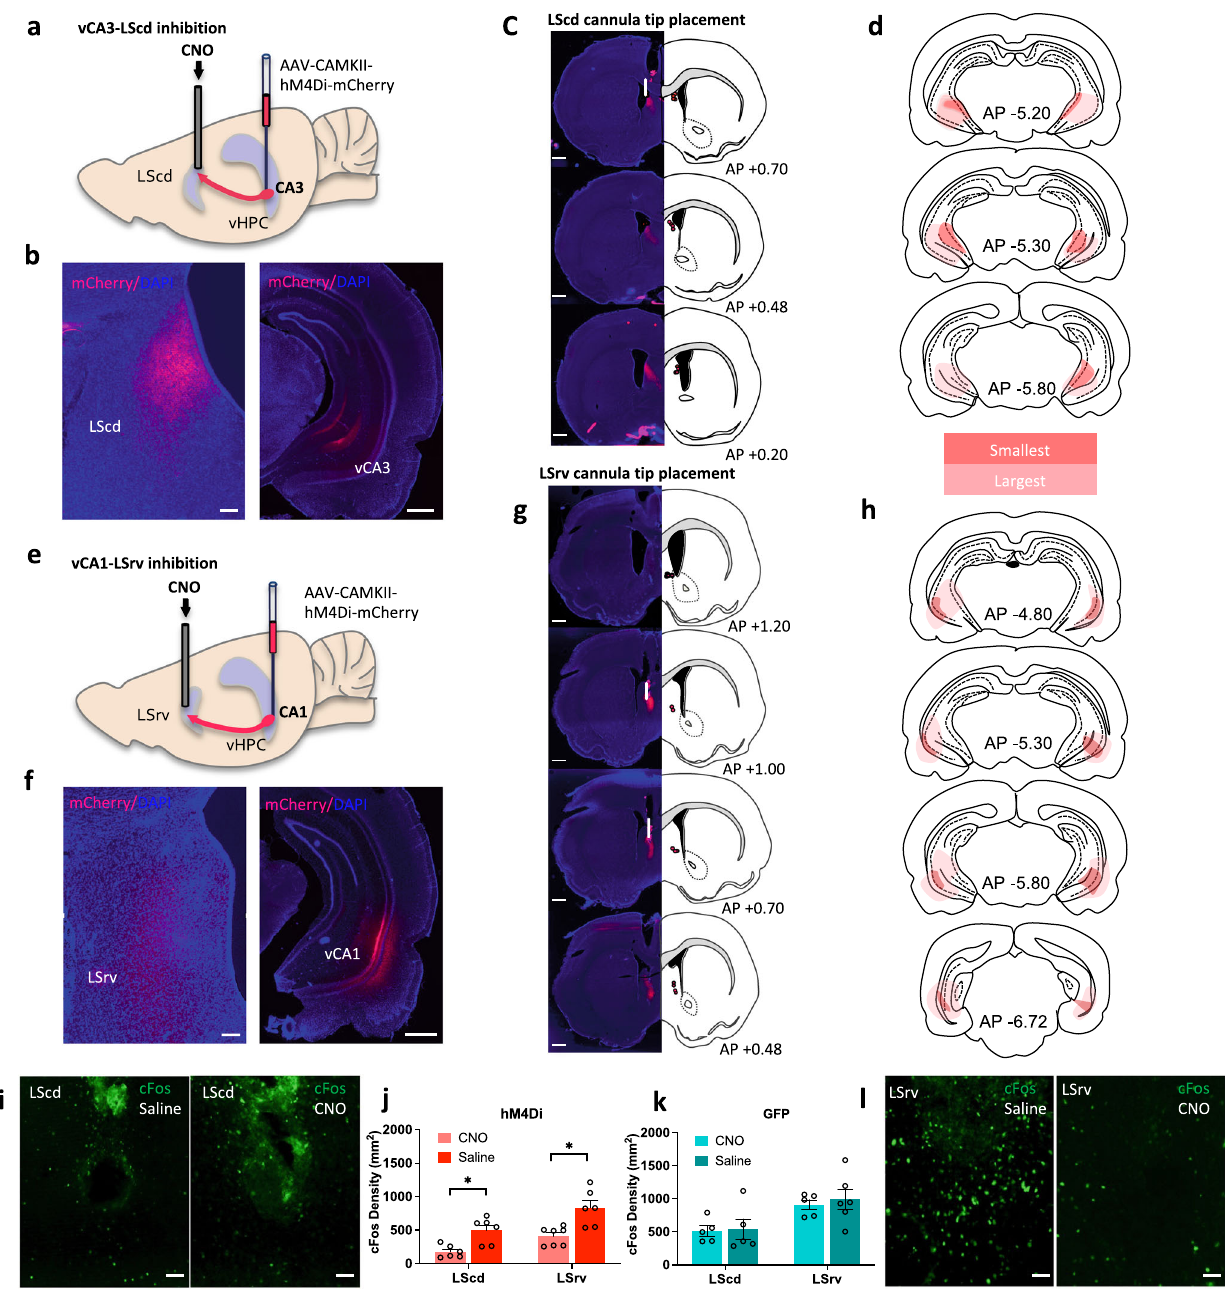
Fig. 2 Experimental schematic and c-Fos results. a Diagram of hM4Di transduction in vCA3 and cannulation in LScd, with b representative DREADDs axonal transduction in the LScd (red) and somatic transduction in vCA3, c cannula placements in the LScd restricted to sections + 0.7 to + 0.2 anterior to bregma 71 , d minimum and maximum DREADDs expression in vCA3 observed in sections -5.20 to -5.80 posterior to bregma 71 . e Diagram of hM4Di transduction in vCA1 and cannulation in LSrv, with f representative DREADDs axonal transduction in LSrv and somatic transduction in vCA1, g cannula placement in the LSrv restricted to sections + 1.2 to + 0.48 anterior to bregma 71 , and h minimum and maximum DREADDs expression in vCA1, observed in sections -4.80 to -6.72 posterior to bregma 71 i , l Representative images of c-Fos expression in the LScd and LSrv of hM4Di-expressing rats following either saline or CNO infusion. j , k Intracerebral CNO infusions attenuated c-Fos expression in areas of the LS that receive hM4Di positive inputs (Drug x Virus: F = 5.17, p = 0.0248; post hoc CA1 hM4Di t = 3.49, p = 0.0022; post hoc CA3 hM4Di t = 3.64, p = 0.0228; Region: F = 25.73, p = 0.0001) (1,38) 7.16 7.21 (1,38) compared to saline controls. EGFP-LScd-CNO n = 5, EGFP -LScd-Saline n = 5, EGFP -LSrv-CNO n = 5, EGFP-LSrv-Saline n = 6. hM4Di-LScd-CNO n = 6, hM4Di-LScd-Saline n = 6, hM4Di-LSrv-CNO n = 7, hM4Di-LSrv-Saline n = 6. c-Fos analyzed by three-way ANOVA, followed by post hoc two-sided t -tests with Bonferroni-Holm correction for multiple comparisons. Data represent mean ± sem. * p < 0.05. * denotes between-subject comparisons. 100 um scale bars for b , f (left), i , l 1 mm scale bar for images b , f (right), c , g . i Cannula track shown by white vertical bar for images in c and d . dHPC dorsal hippocampus, LScd caudodorsal lateral septum, LSrv rostroventral lateral septum, vHPC ventral hippocampus. Source data are provided as a Source Data fi